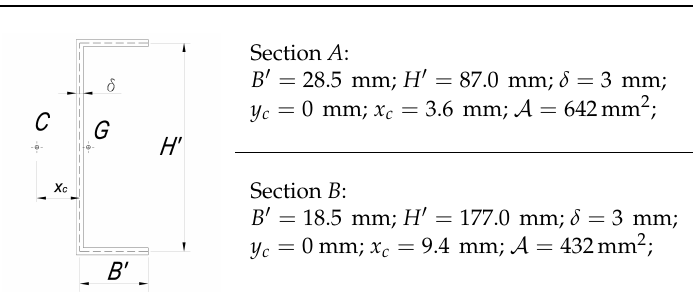
S 420 structural steel. Table 2 reports beam mechanical properties: Young modulus E, shear modulus G and yield strength f y . A right-hand orthogonal coordinate system Gxyz is introduced, where z denotes the undeformed longitudinal axis of the beam and x and y the principal bending axes. The origin of these axes is located at the center G A (Figure 1). The shear centers of the end cross sections are denoted C A and C B , respectively. Table 1. End cross-sections ( A and B ) details.